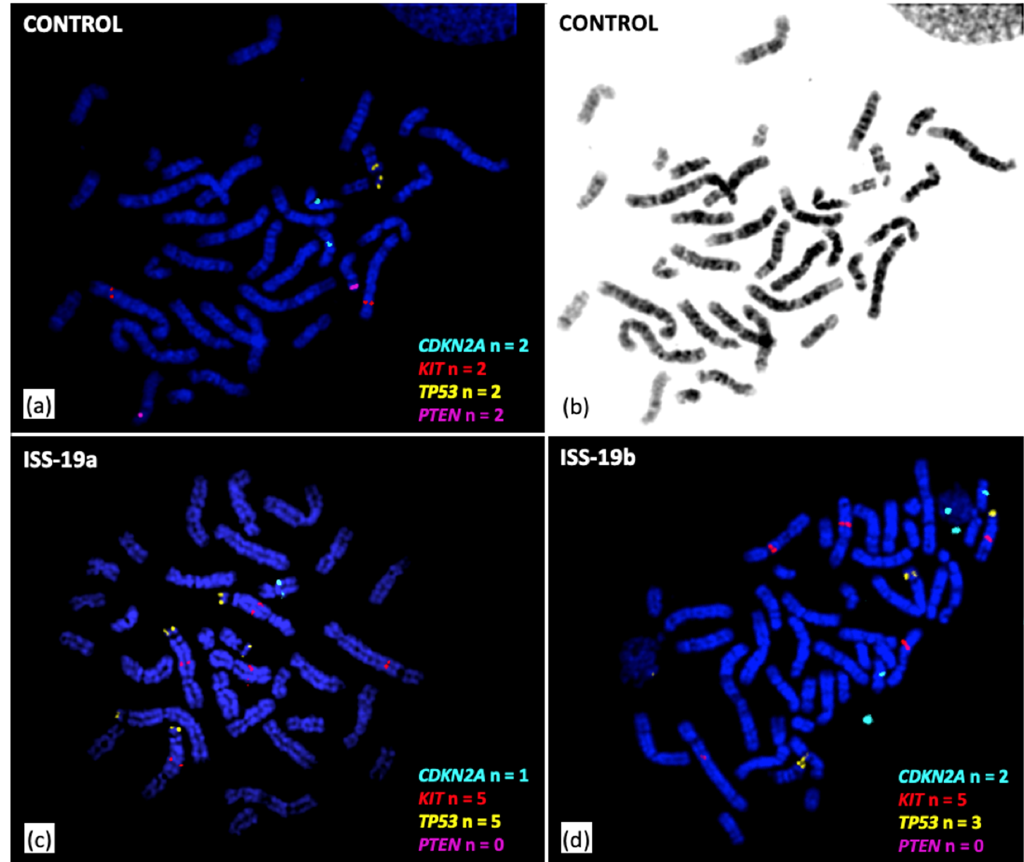
Figure 5. Targeted fluorescence in situ hybridization (FISH) analysis of ISS-19a and ISS-19b. (a) Differentially labeled FISH probes representing four genes were hybridized to control metaphase chromosome preparations from clinically healthy donor cats. This demonstrated the unique localization of these probes to fcaD4:46.13 Mb ( CDKN2A/B , aqua probe), fcaB1:162.44 Mb ( KIT , red probe), fcaE1:2.49 Mb ( TP53 , gold probe) and fcaD2:7.42 Mb ( PTEN, purple probe), with the expected copy number (n = 2) in all control cells evaluated. (b) DAPI-banded image of the metaphase spread shown in (a), enabling confirmation of the expected chromosome location for each probe. (c) and ( d) Representative images of FISH analysis of individual cells from ISS-19a and b, respectively, indicating the DNA copy number of the same panel of four probes. Both specimens exhibited hyperdiploidy and evidence of complex karyotypic reorganization. The copy number of CDKN2A/B was grossly balanced within the population of cells scored for both specimens (mean 1.7 in ISS-19a and 2.0 in ISS-19b). Both KIT and TP53 showed elevated copy number, with a mean of 5.8 and 4.9, respectively, in ISS-19a, and 5.0 for both probes in ISS-19b. The majority of cells in both specimens exhibited one or more derivative chromosomes harboring both KIT and TP53 signals (87% of ISS-19a cells and 94% of ISS-19b cells), suggestive of fusion between regions of fcaB1 and E1. PTEN probe signal was undetectable in both ISS-19a and b, indicative of homozygous deletion. Data from FISH analysis were consistent with those obtained by oaCGH analysis, and in combination support the origin of ISS-19b as a recurrence of the original ISS-19a mass.